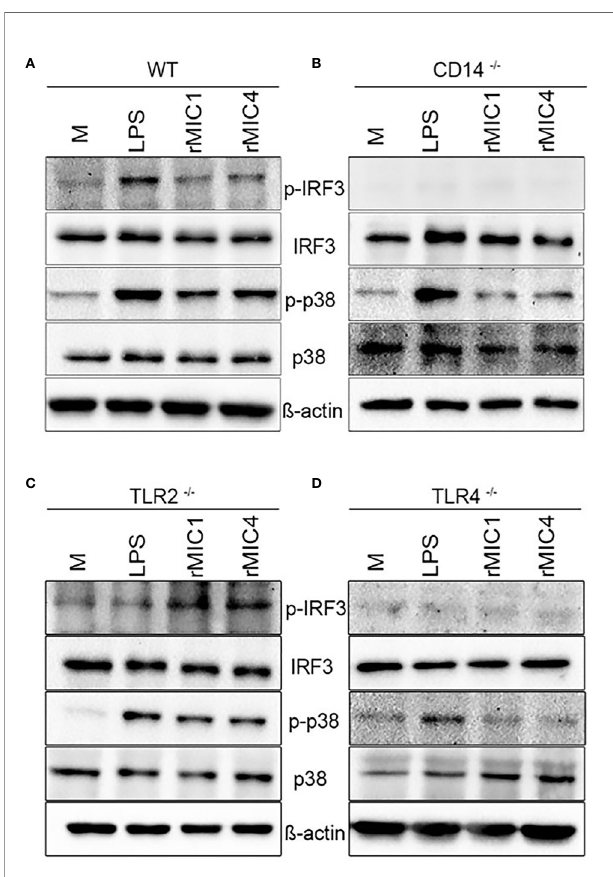
FIGURE 3 | IRF3 phosphorylation in MIC1- or MIC4-stimulated BMDMs depends on CD14 and TLR4. IRF3 and P38 phosphorylation were assessed by western blotting of lysates of WT (A) , CD14 -/- (B) , TLR2 -/- (C) , and TLR4 -/- (D) BMDMs, which had been stimulated with medium only (M), LPS, MIC1, or MIC4 for 30 min. Antibodies against phosphorylated and unphosphorylated IRF3 and P38 were used; anti- b -actin was used as a loading